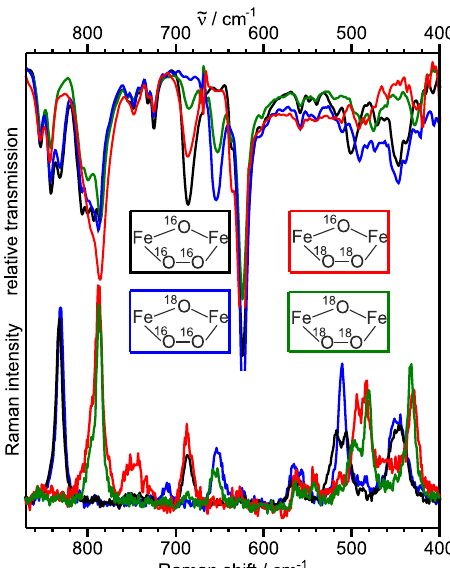
Fig. 3 Vibrational characterization of [(susan 6-Me ){Fe III ( μ -O)( μ -O 2 ) Fe III }](ClO 4 ) 2 . Resonance Raman (bottom, 633 nm (15,800 cm − 1 ) excitation) and FTIR spectra (top) measured on solids at room temperature for the four different iostopomers of [(susan 6-Me ){Fe III ( μ -O)( μ -O 2 )Fe III }] (ClO 4 ) 2 indicated by the representation of their central cores and the color scheme